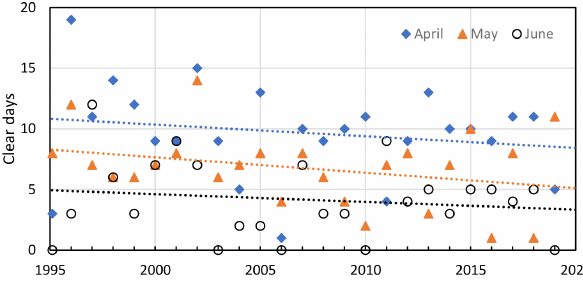
Figure 14. Number of monthly clear-sky days observed in Ny- Ålesund in April, May, and June 1995–2019. Trends are indicated as dotted lines. Data are from the NCCS database.